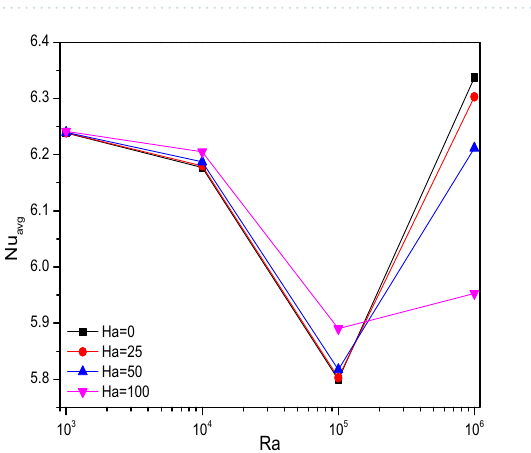
Figure 3. Variations of the streamlines ( (cid:31) ) and isotherms ( T ) with various Rayleigh number ( Ra ), Da = 0.01 , ϕ = 0.02 , ε = 0.2 , N = 4 , r = 0.1 and ω = 0 .